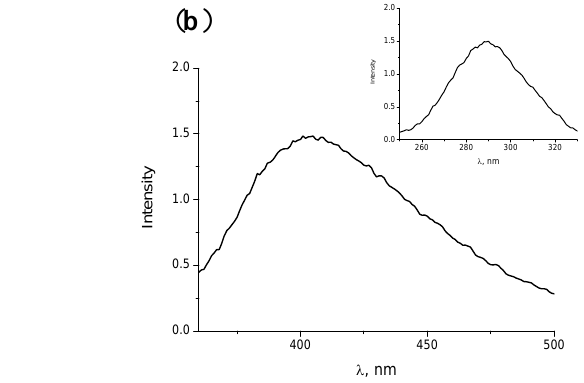
Figure 4. Fluorescence emission ( λ (b). Inset: corresponding excitation spectra.